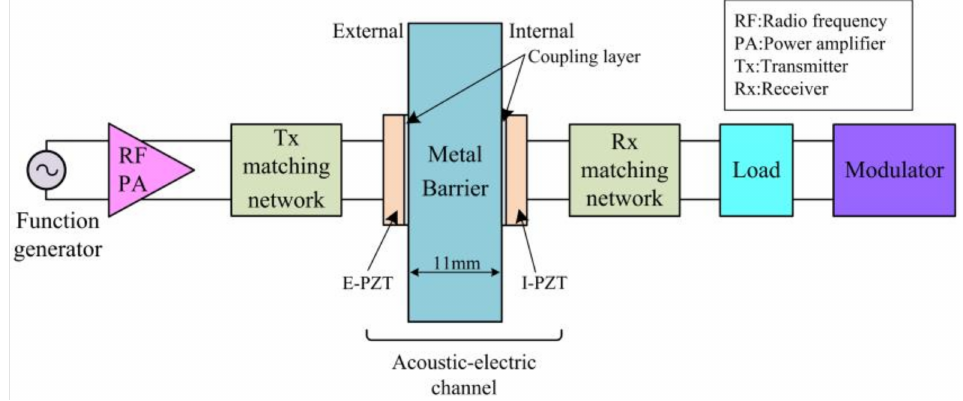
Figure 1. Block diagram of the ultrasound based simultaneous energy transmission and communica- tion